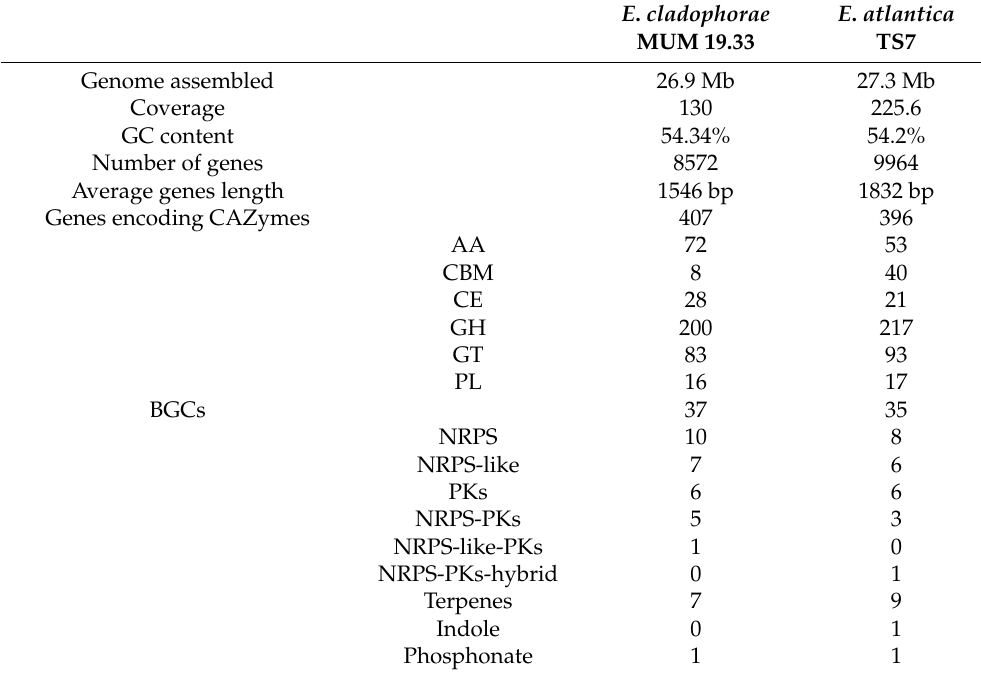
Table 4. Overview of genome assembly and gene statistics for Emericellopsis cladophorae MUM 19.33 and E . atlantica TS7. AA: auxiliary activity; CBM: carbohydrate binding modules; CE: carbohydrate esterases; GH: glycoside hydrolases; GT glycosyltransferases; PL: polysaccharide lyases; NRPS: non-ribosomal peptide synthases; PKs: polyketide synthases. E .